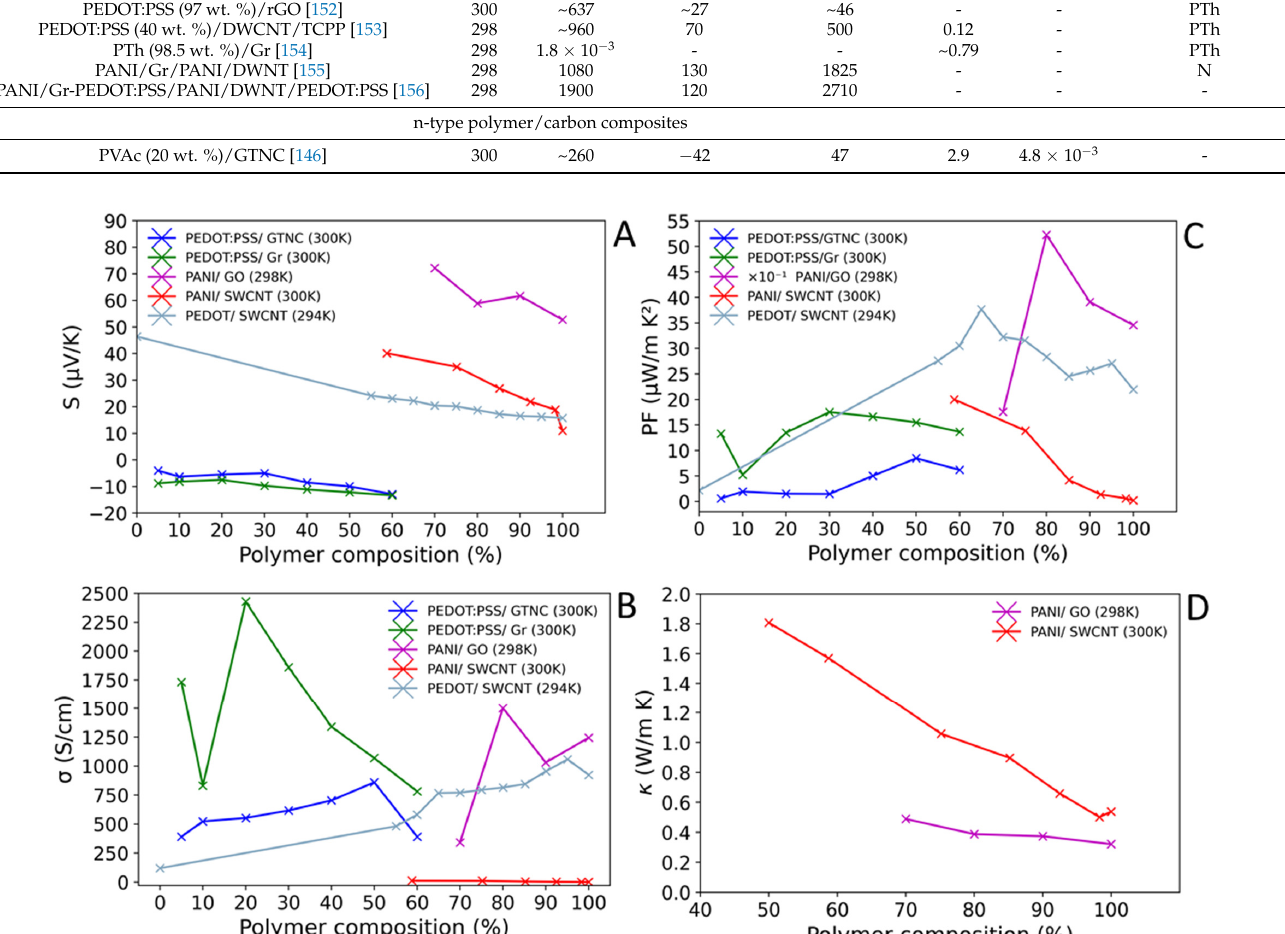
Figure 5. Comparison of TE parameters of polymer/carbon composites as a function of the polymer composition (%). ( A ) S . ( B ) 𝜎 . ( C ) PF. ( D ) 𝜅 . PANI/GO [141], PEDOT:PSS/GTNC [146], PE- DOT:PSS/Gr [146], PEDOT/SWCNT [143], and PANI/SWCNT [157]. Note, values for ( C ) PANI/GO have been presented ×10 − 1 .